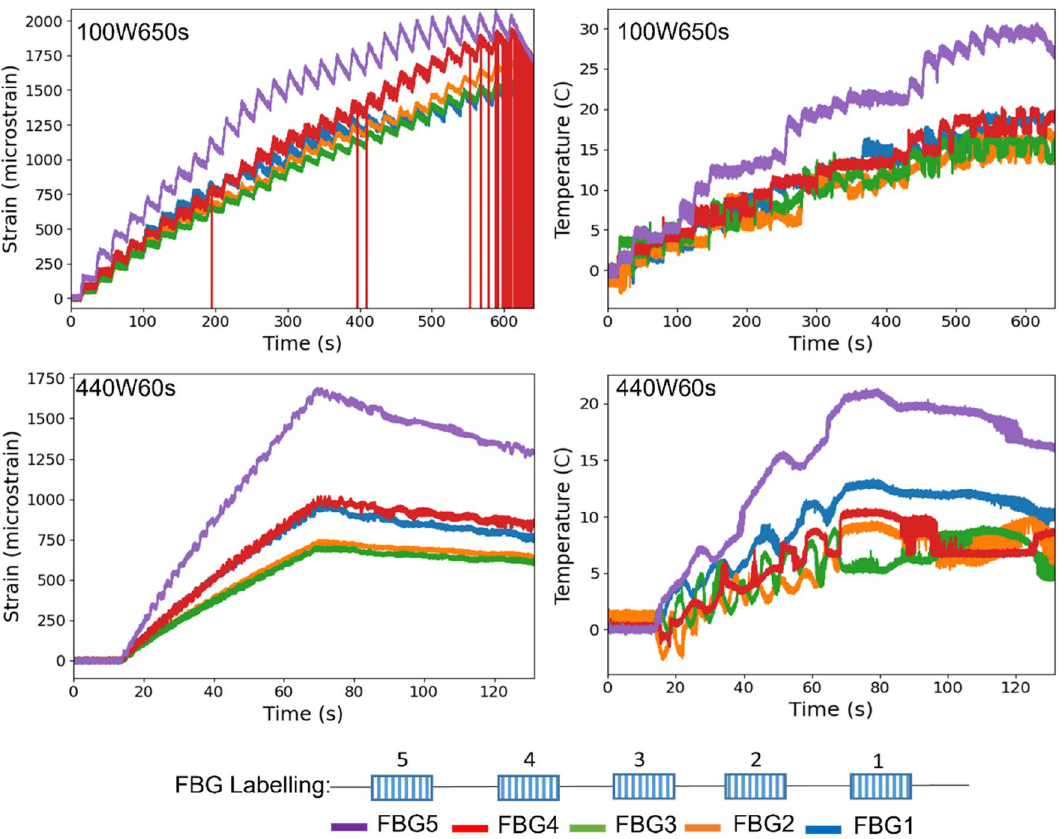
Figure 25. Strain and temperature evolution of the neat epoxy sample under 100 W and 440 W.